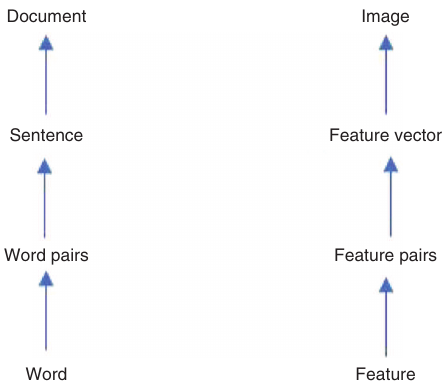
Figure 1: Semantic Comparison of Text and Image.